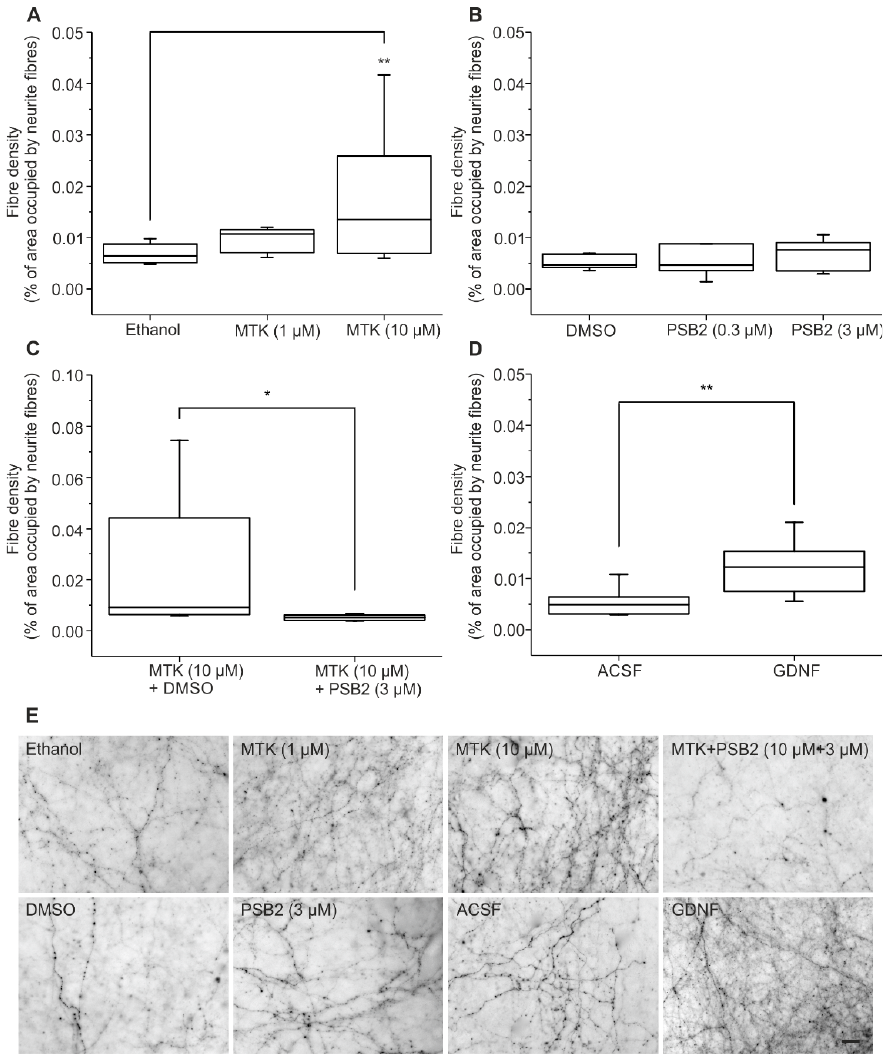
Figure 2. Neurite outgrowth quantification. ( A – D ) Neurite fibre density was quantified after treatment with ( A ) MTK, ( B ) PSB-16484 (PSB2), ( C ) MTK and PSB-16484 (PSB2) and ( D ) GDNF using biocytin-tracing. Data are shown as box plots. The number n of animals being used was for ( A ) n ≥ 9, ( B ) n = 4, ( C ) n ≥ 5, ( D ) n = 8. For ( A , B ) ANOVA on Ranks was followed by Tukey’s test, for ( C ) Mann–Whitney test was applied and for ( D ) t -test was applied; * p < 0.05, ** p < 0.01. ( E ) Pictures of biocytin-labelled fibres in the border region after application of Ethanol, MTK (1 µ M), MTK (10 µ M), MTK (10 µ M, pre-treatment) + PSB-16484 (PSB2, 3 µ M), DMSO, PSB-16484 (PSB2, 3 µ M), ACSF and GDNF. Scale bar: 20 µ m for